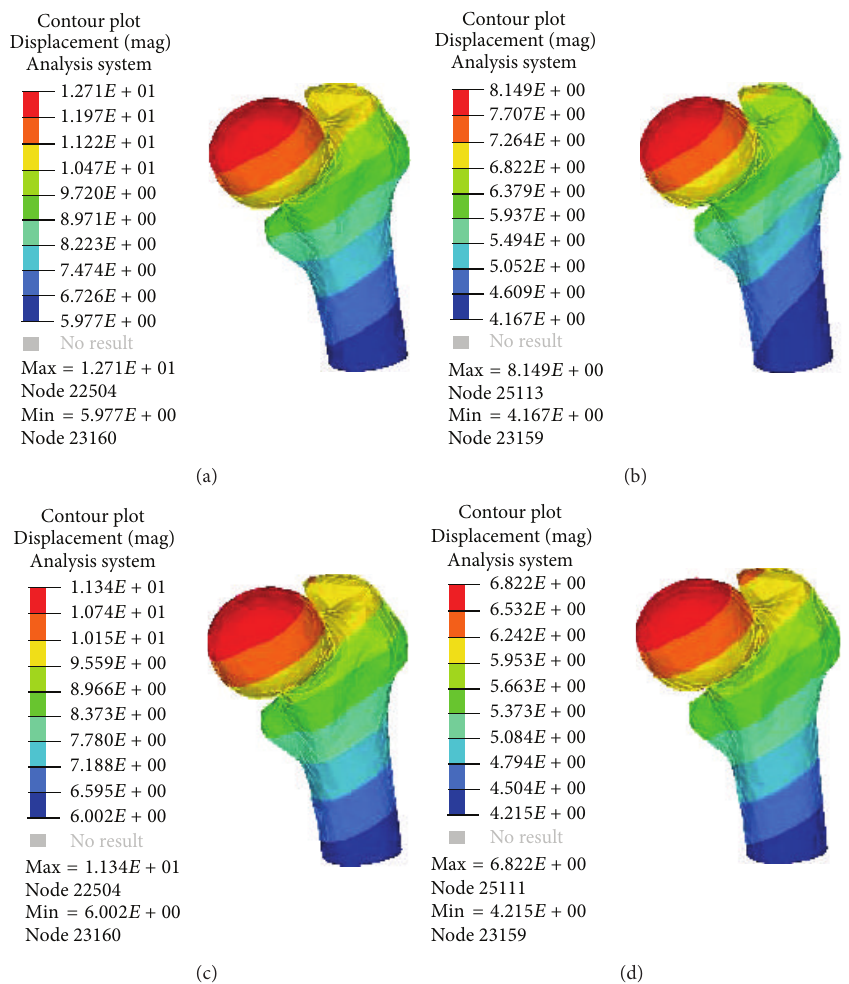
Figure 3: Deformation of the treated femoral head in the two different healing stages. (a) PFNA-II model in SCS; (b) A2FN model in SCS; (c) PFNA-II model in HCS; (d) A2FN model in HCS.